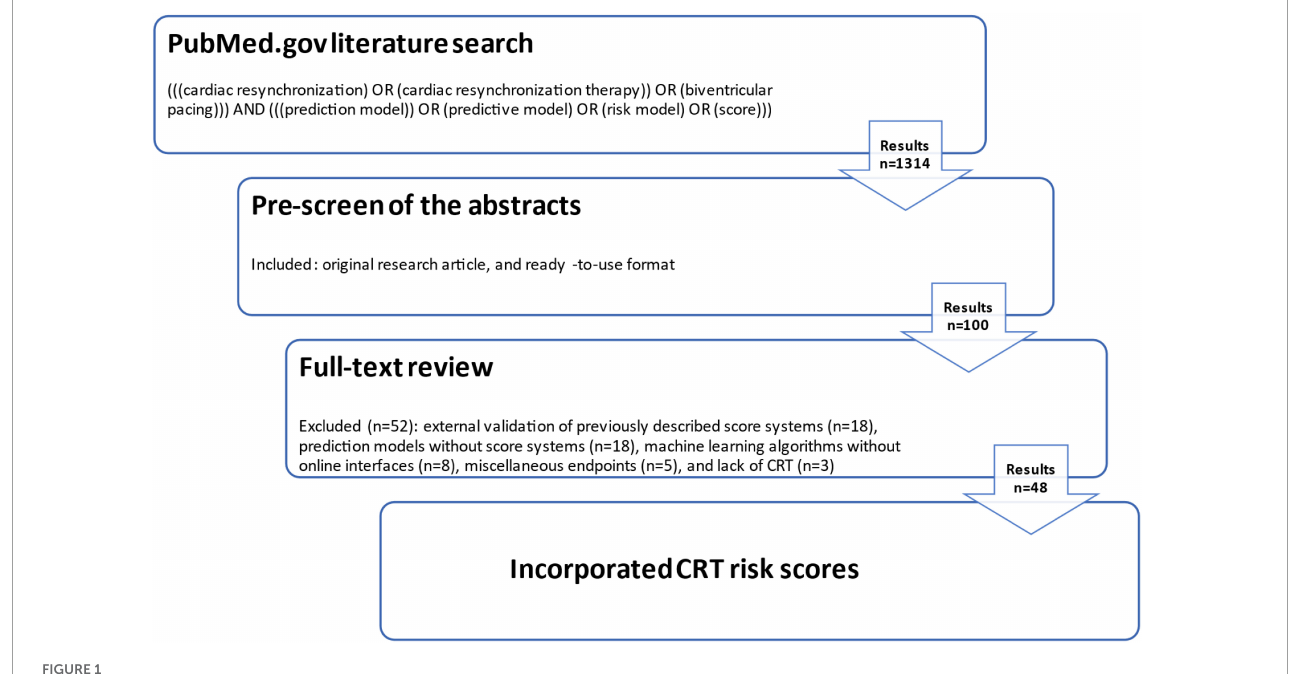
FIGURE1 Flowchart of the review